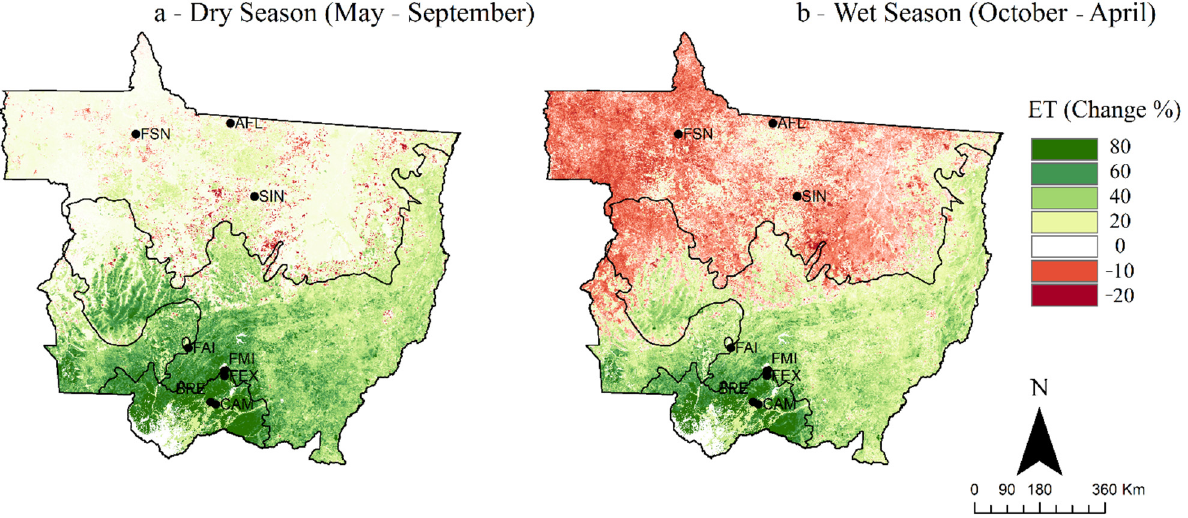
Figure 9. Relative difference in the average ET MODIS of the state of Mato Grosso between 2000–2009 and 2010–2019 during the ( a ) dry season (May–September) and ( b ) wet season (October–April). Positive relative difference indicates that the average ET MODIS in 2010–2019 is higher than in 2000–2009.